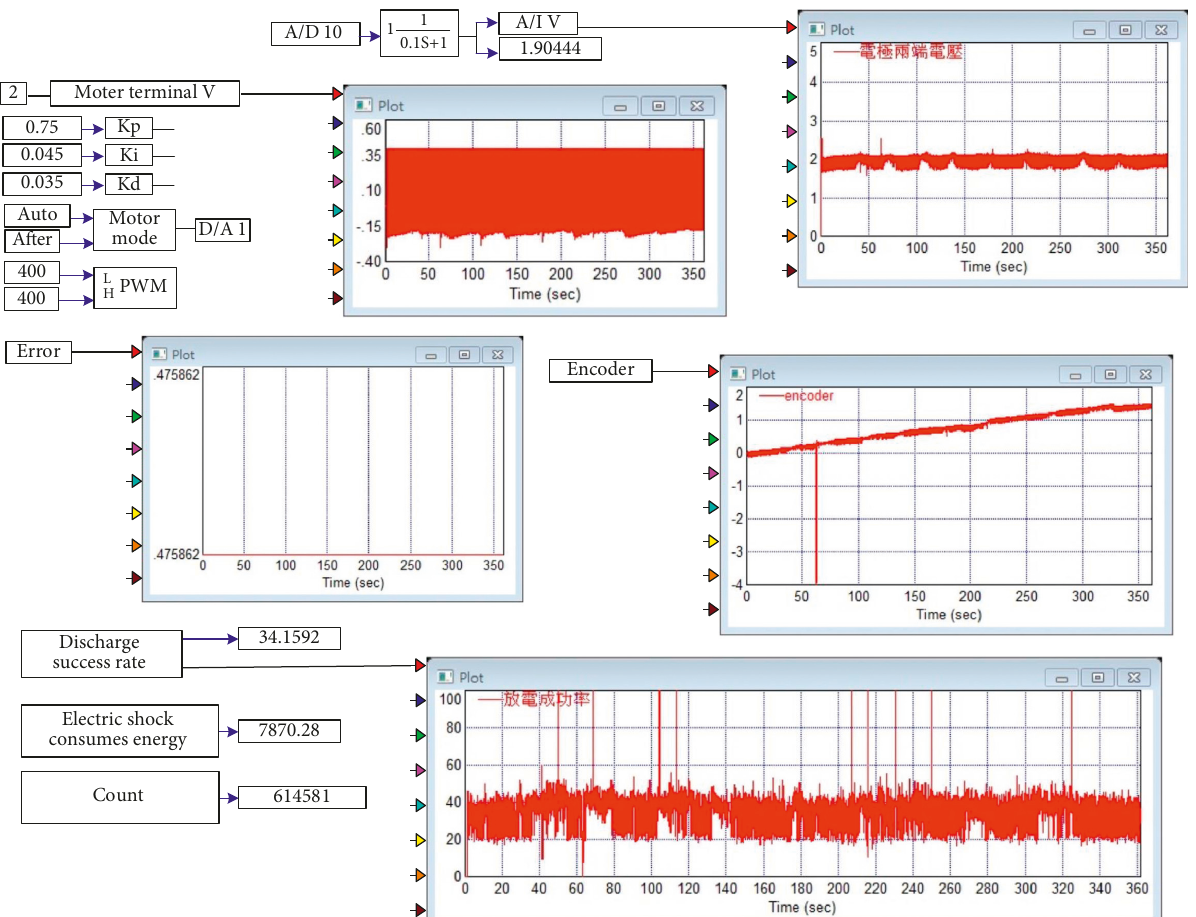
Figure 6: Diagram of Vissim prog. (arcing in DW for 6